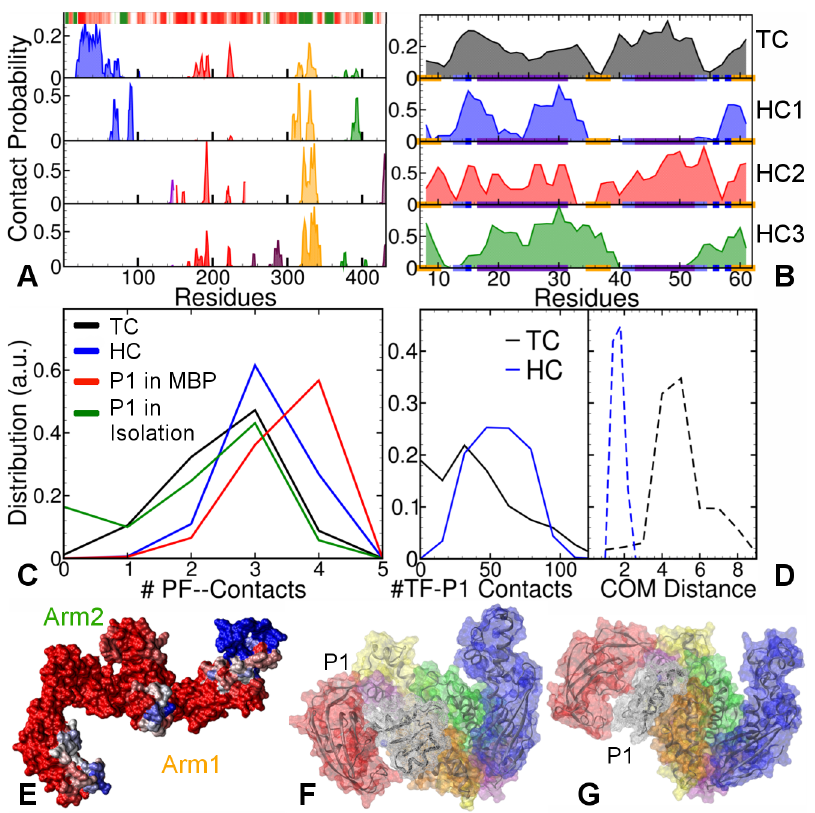
Fig 3. Comparisons between MD simulations of folded P1 with TF in Touching Complex (TC), and Hugging Complexes (HCs). A. Contact probabilities of TF residues with P1 in four TF-P1 Touching and Hugging Complexes. The barcode plots the hydrophobicity map of TF: color-scaled from red (hydrophilic) to green (hydrophobic). B. Corresponding contact probabilities of P1 residues with TF plotted in the same order of panels. The secondary structure of P1 is represented on the x-axis: orange regions for β – strands, indigo for α – helices, iceblue for turns, dark blue for bends, and the rest represents coils. C. Distributions of the number of intact PF-contacts in folded P1. D. Distributions of the number of TF-P1 contacts (left panel) and TF-P1 COM distance (right panel), in Touching Complexes(black lines) and Hugging Complexes (blue lines), respectively. E. Visualization of the interaction sites on TF ’ s surface the P1 in the TC, colored from red (least likely) to blue (most likely). F. Representative final TC conformation, with P1 shown in transparent white colored wire-mesh. G. Representative final HC